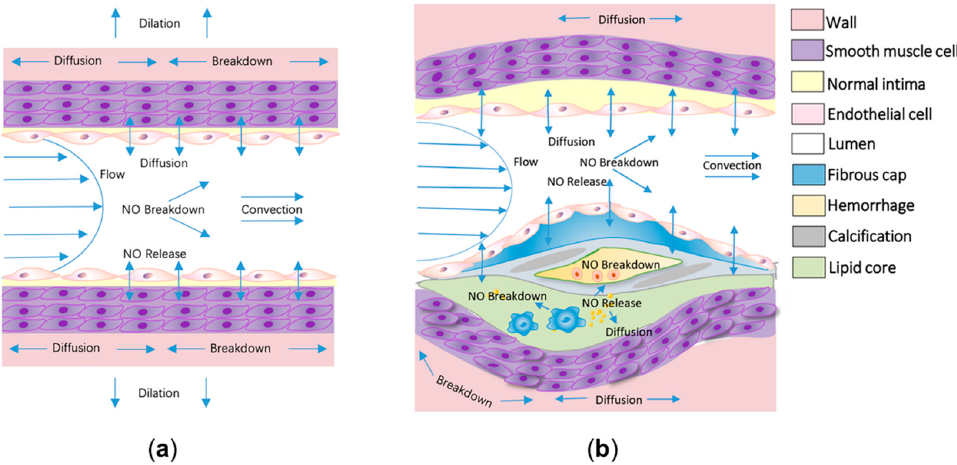
Figure 1. The delivery process of nitric oxide (NO) in physiological and atherosclerotic arteries. ( a ) At physiological sites, NO is mainly released by endothelial cells modulated by the shear flow. The released NO would be quickly delivered to neighboring arterial walls, leading to vasodilation. The diffusion, convection, and reaction processes of NO are shown in the schematic diagram. ( b ) In atherosclerotic arteries, in addition to the delivery process in physiological arteries, massive amounts of NO would release from the activated macrophages in the lipid core and the released NO would be synchronously consumed by hemoglobin in the intraplaque hemorrhage.